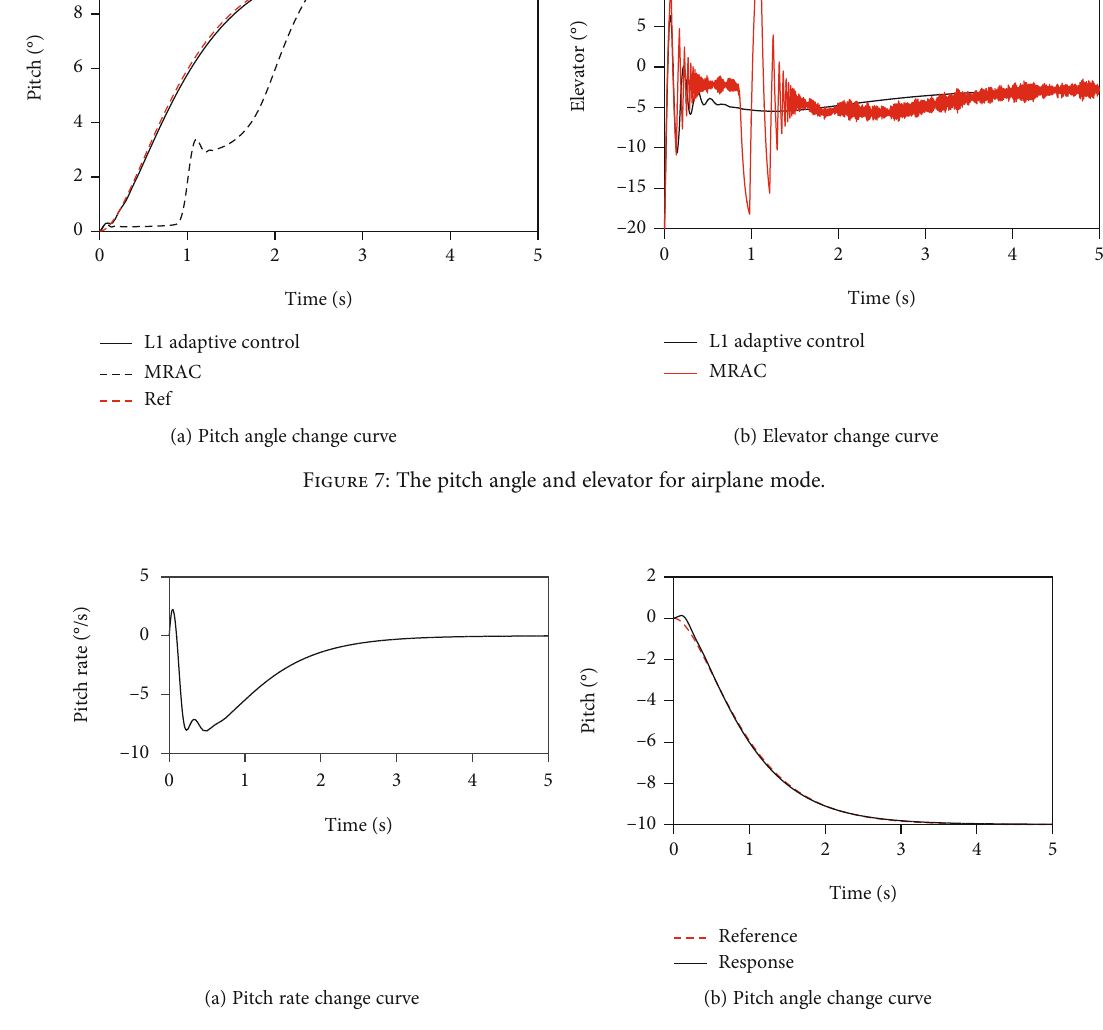
Figure 8: The pitch rate and pitch angle of step